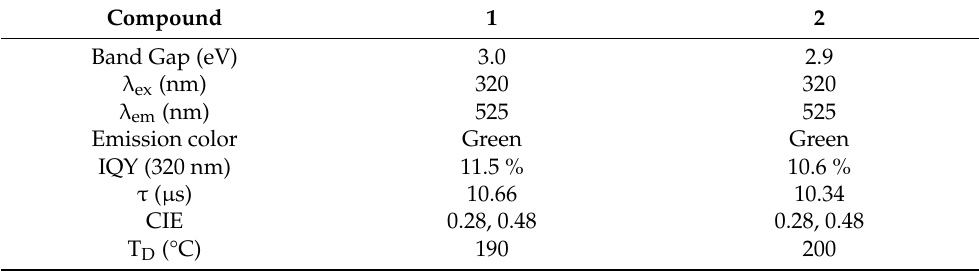
Table 2. Summary of photophysical properties of 1 and 2.